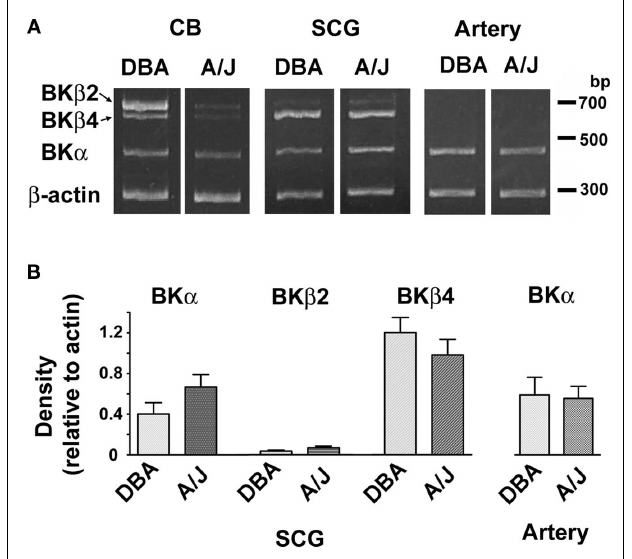
FIGURE 2 | (A) Agarose gel electrophoresis of RT-PCR products for BK channel subunits in the CB, the SCG, and the carotid artery (Artery). Multiplex PCR was performed for β -actin, BK α , BK β 2, and BK β 4. (B) Semi-quantitative analysis of gene expression for BK subunits was shown. The density of the each band was measured and normalized relative to the expression of β -actin in the same sample. Note that no strain differences were observed in the SCG ( n = 5) and the artery ( n =